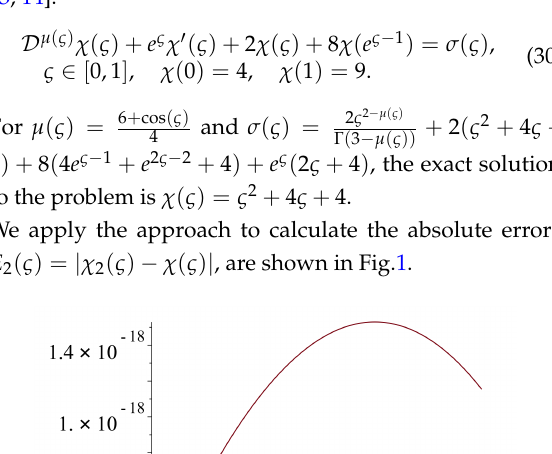
Fig. 1. Absolute errors of the approximate solution of problem (30) for Λ = 2.